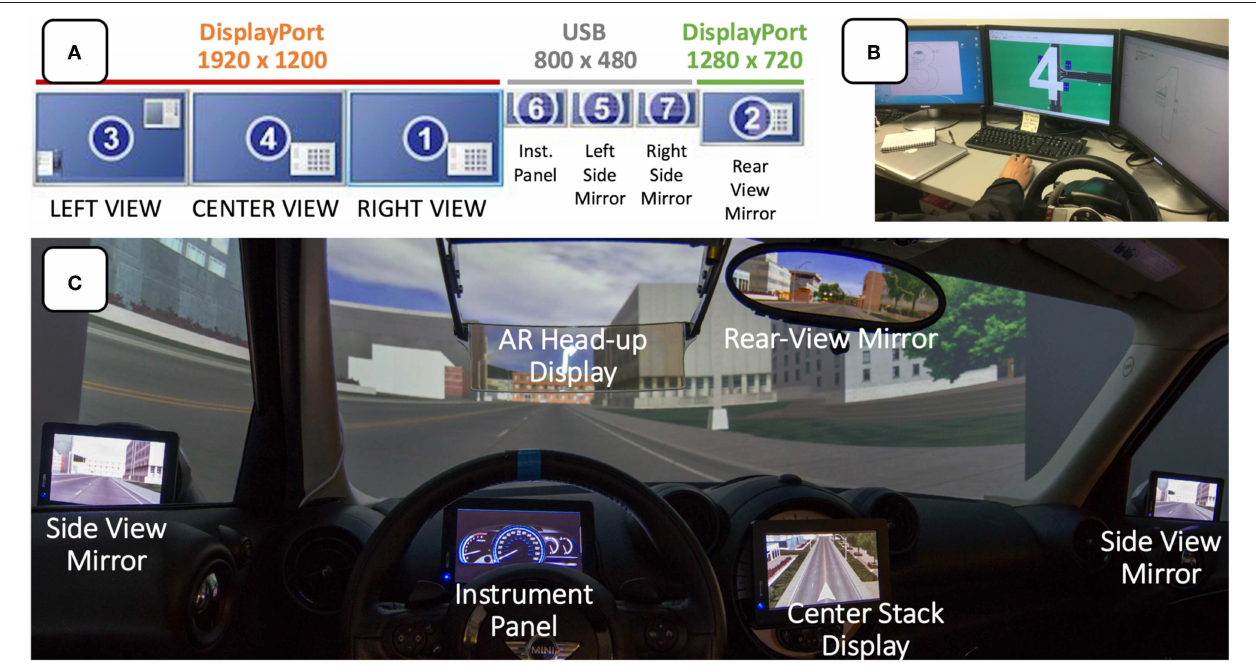
FIGURE 2 | The logical arrangements of 7 AR DriveSim screens with resolution and physical connections noted (A) ; experimenter’s control station (B) , and an annotated view from inside the Mini Cooper cab (C) . Note that the AR HUD and Center Stack displays are connected to a separate computer dedicated to UI